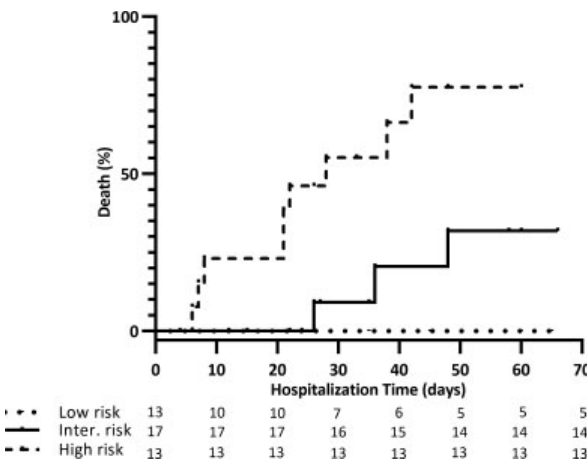
Fig. 6 Cumulative incidence of death by the PaO2/FiO2 þ vWF activity þ Neutrophils score. The cumulative incidence of death was 0% in the low-risk (0/13; IC 95%, 0%), 32% in the intermediate-risk (3/17; IC 95%, 1.6 – 62%) and 78% in the high-risk group (9/13; IC 95%, 52 –